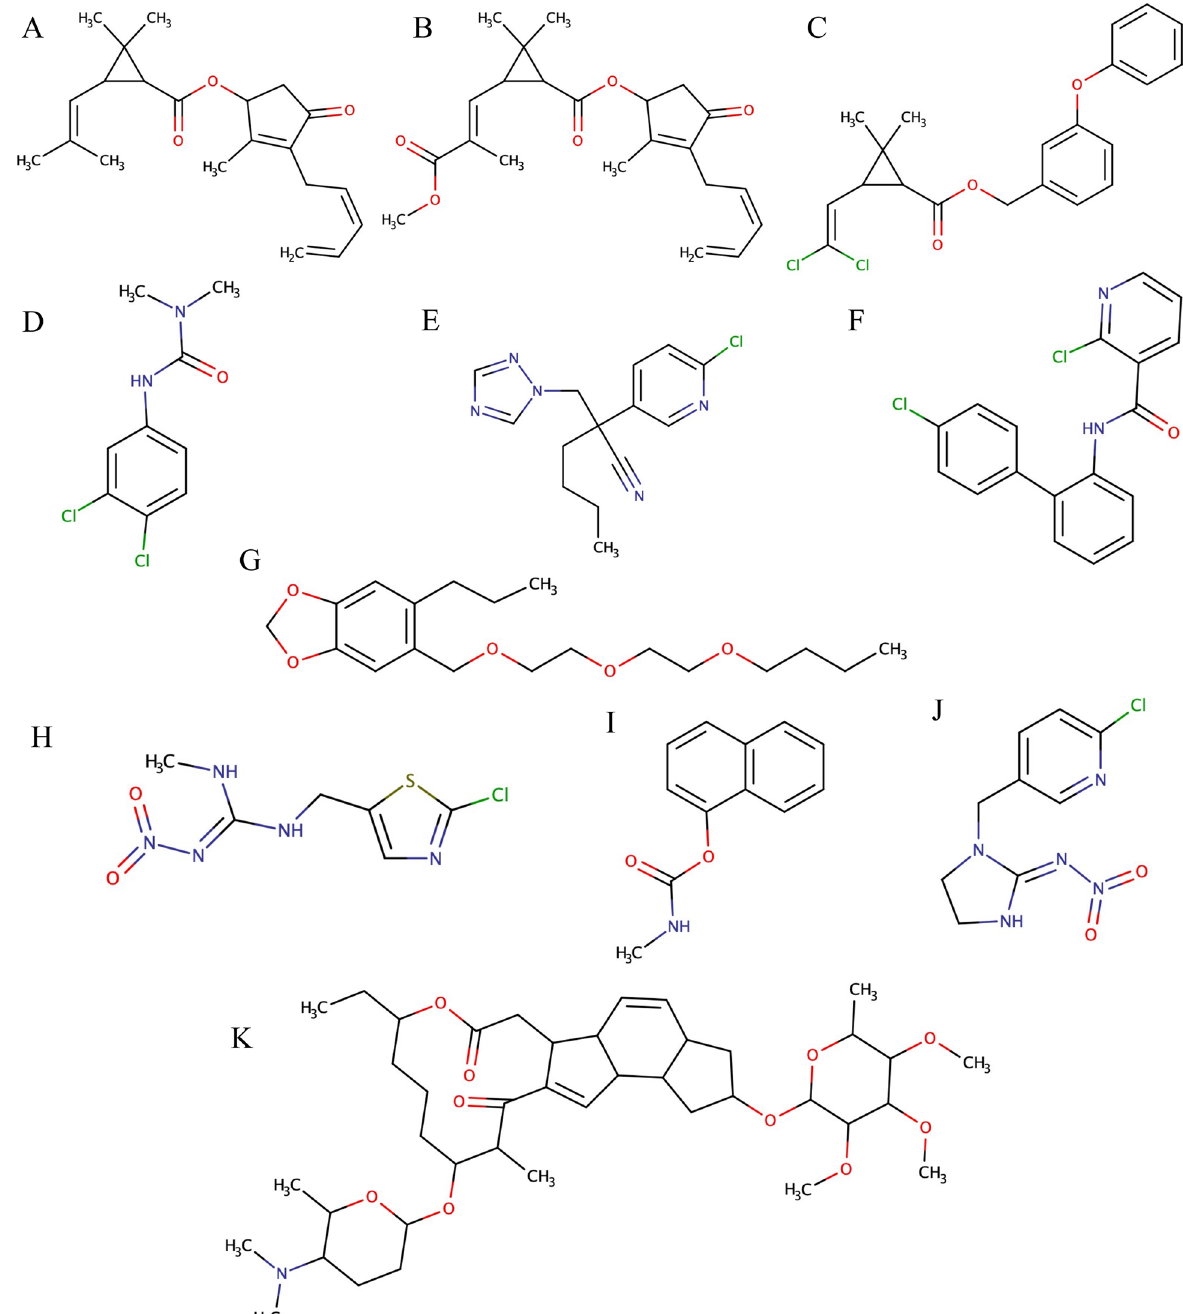
Fig. 2 Structures of pesticides investigated for the present HPLC-QQQ method. A pyrethrin I, B pyrethrin II, C permethrin, D diuron, E myclobutanil, F boscalid, G piperonyl butoxide, H clothianidin, I carbaryl, J imidacloprid, K Spinosyn